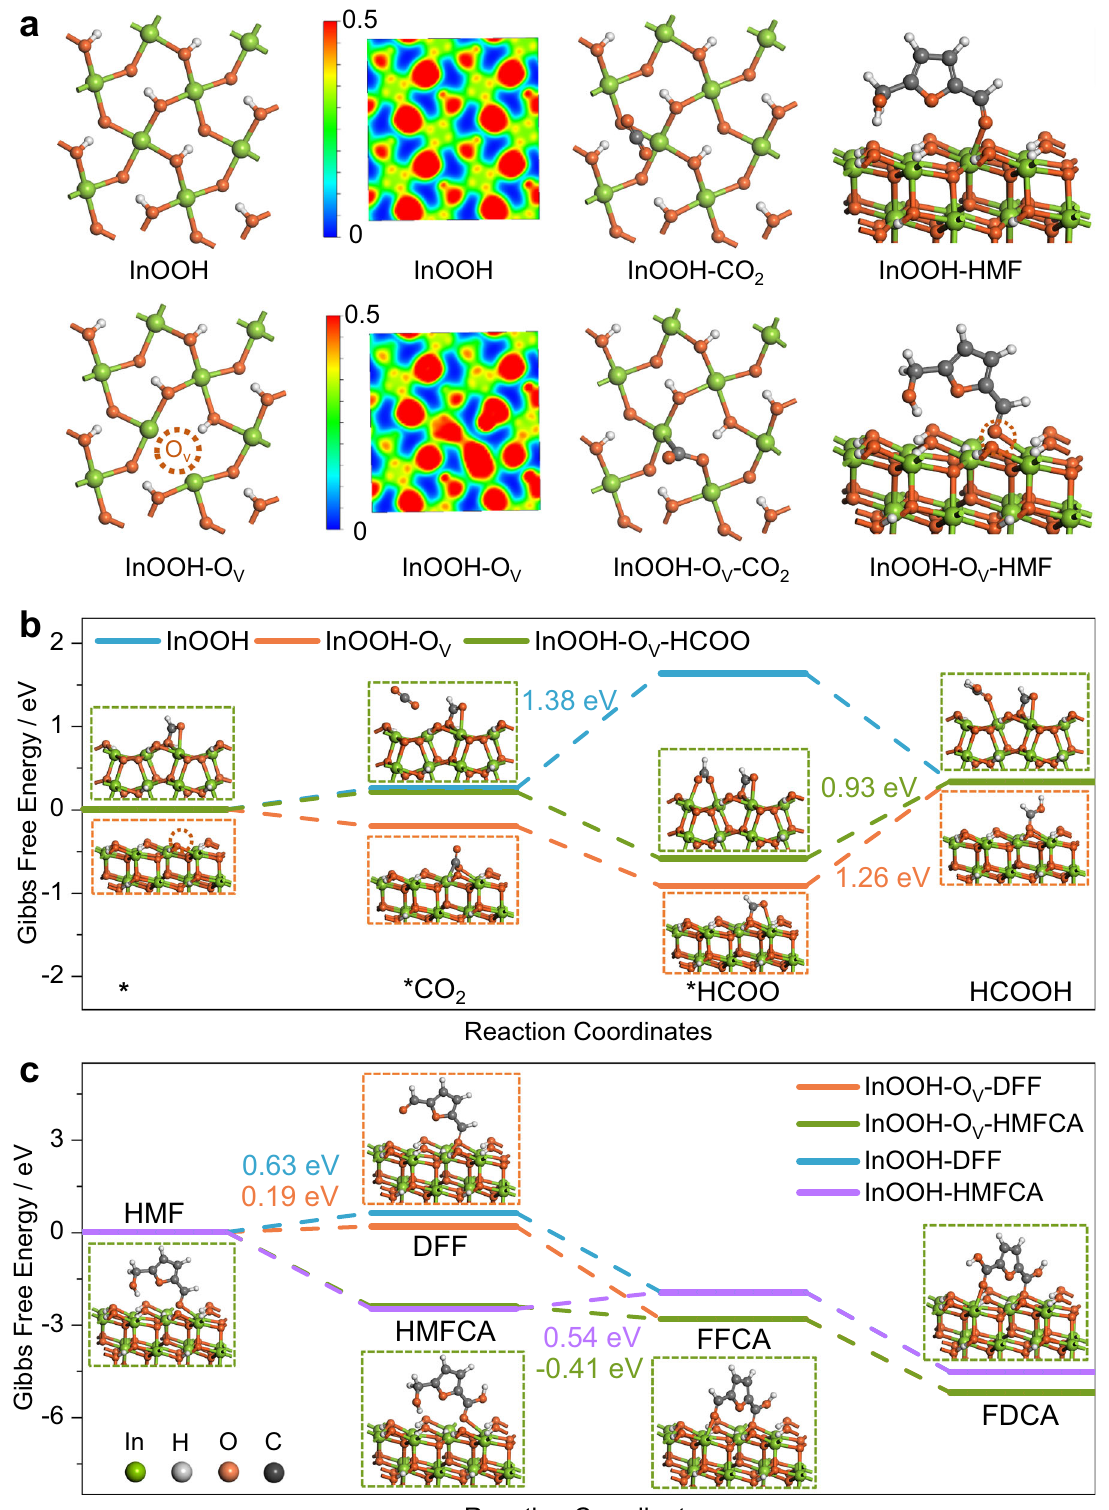
Fig. 5 | Theoretical calculations. a The diagrams (top view) of built models of InOOH and InOOH-O V and their corresponding ELF, and the adsorption con fi g- urations of CO 2 and HMF. b Free energy diagramfor CO 2 RR on InOOH, InOOH-O V , and InOOH-O V -HCOO with the intermediate adsorption con fi gurations for InOOH-